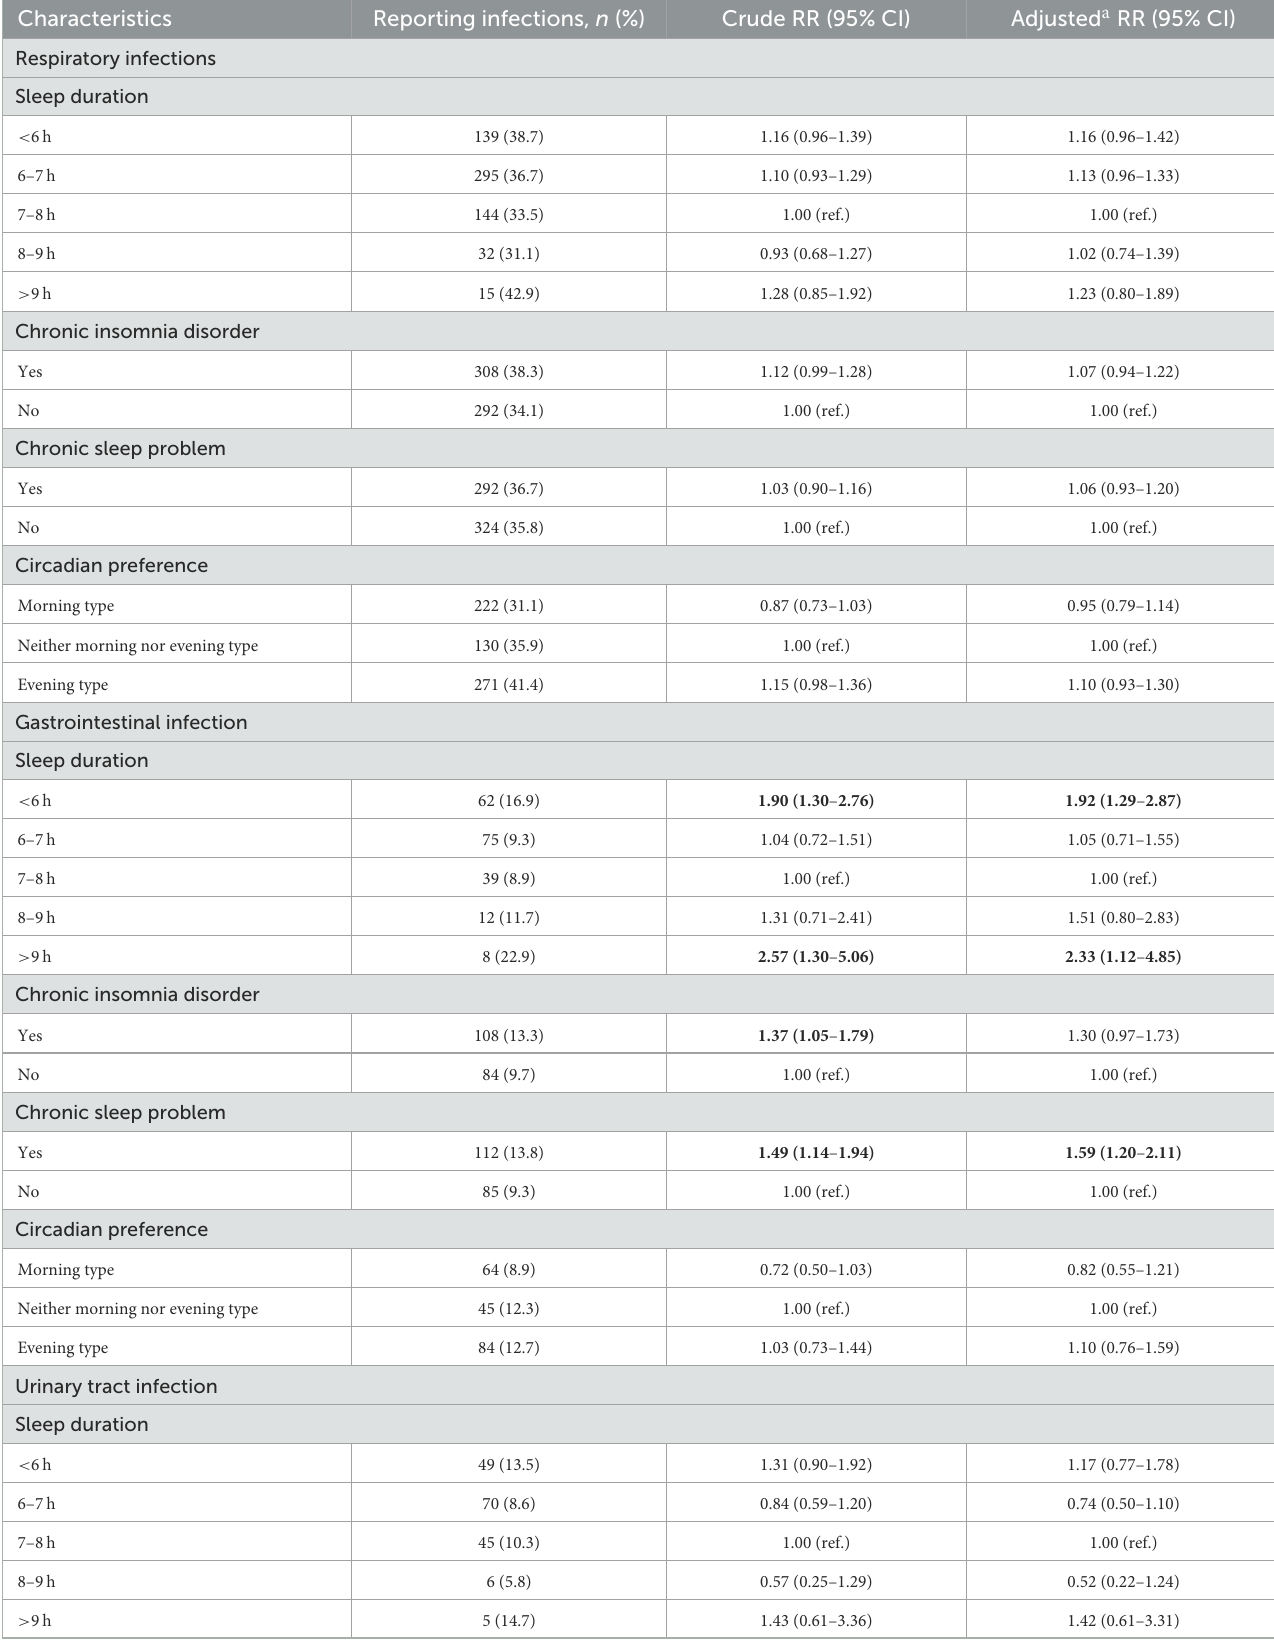
TABLE 3 Absolute risk, crude and adjusted relative risk (RR) with 95% confidence interval (CI) for respiratory, gastrointestinal and urinary tract infection among 1,848 patients visiting their GPs in the spring and fall of 2020, statistically significant results are indicated in bold.